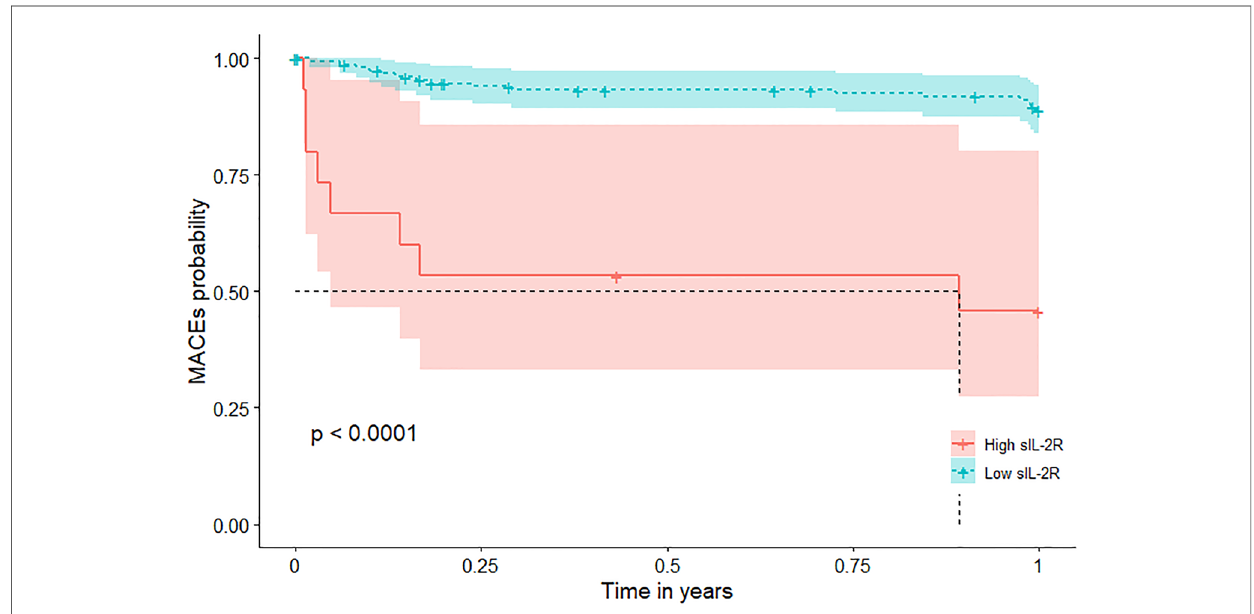
FIGURE 1 MACEs According to sIL-2R Levels in patients with MI during 1-year follow-up. Kaplan-Meier plots of MACEs during 1-year follow-up according to high (greater than the cutoff value 807 U/ml) or low sIL-2R (less than or equal to 807 U/ml). sIL-2R was measured after a 12-h overnight fast on the second day of admission of CCU. CCU, coronary care unit; IL, interleukin; MACEs, major adverse cardiovascular events; MI, myocardial infarction; sIL-2R, soluble IL-2